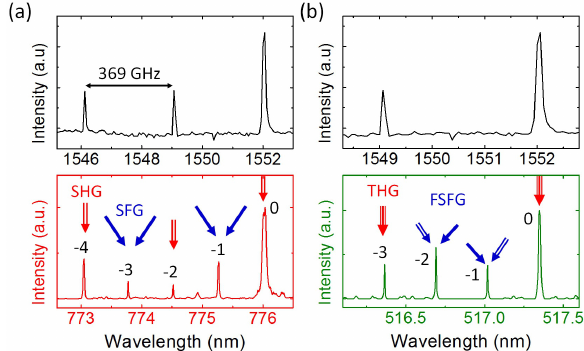
Figure 11: A portion of IR comb spectra (top) and the corresponding visible comb spectra extracted from Fig. 10 (bottom). (a) Red comb generation from SHG and SFG. (b) Green comb generation from THG and FSFG. IR: infrared; SHG: second harmonic generation; SFG: sum frequency generation; THG: third harmonic generation; FSFG: four-wave sum frequency